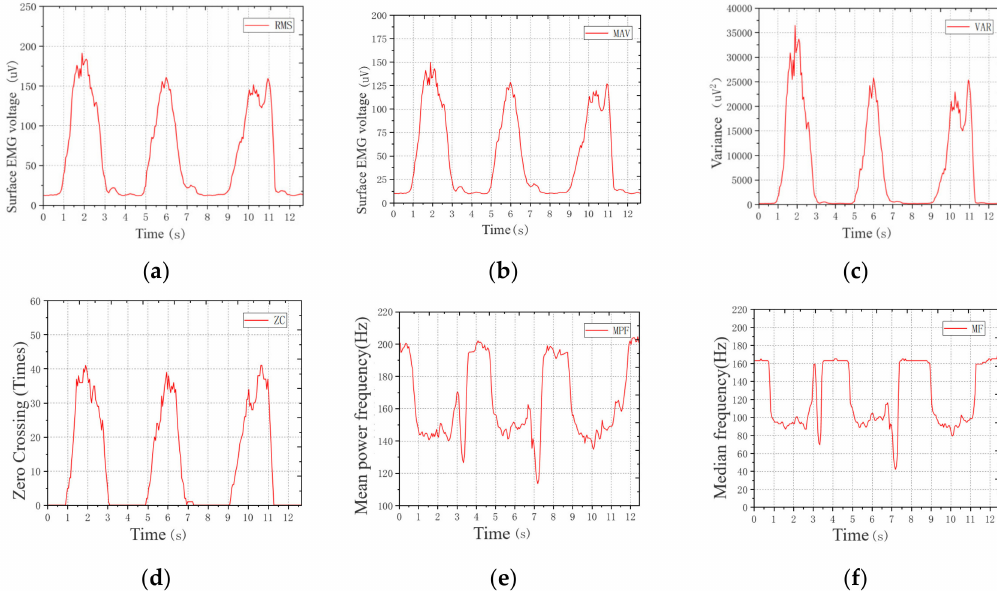
Figure 5. Feature extraction of surface electromyography on rectus femoris in the squatting-standing motion mode. ( a ) Root mean square (RMS), ( b ) mean absolute value (MAV), ( c ) variance (VAR), ( d ) zero crossing (ZC), ( e ) mean power frequency (MPF), and ( f ) median frequency (MF).